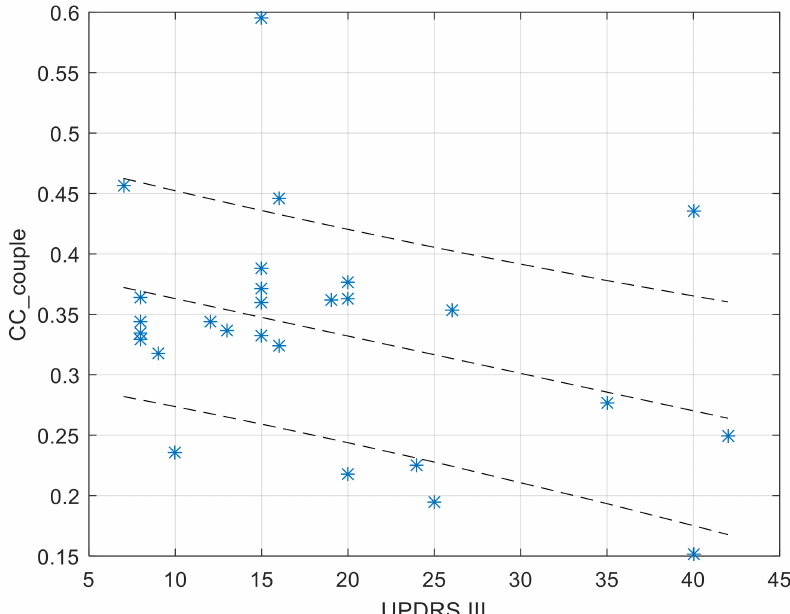
Figure 4. Values of CC_couple_PH in function of the UPDRS score of the dyad component with PD. The regression function is completed by its 95% confidence interval.